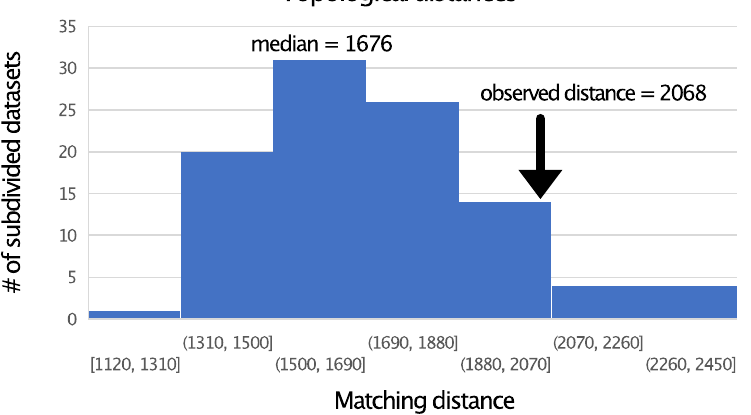
Figure 5. Results of the random subdivision analysis for topological distances based on matching distances between the TM and ExM trees.